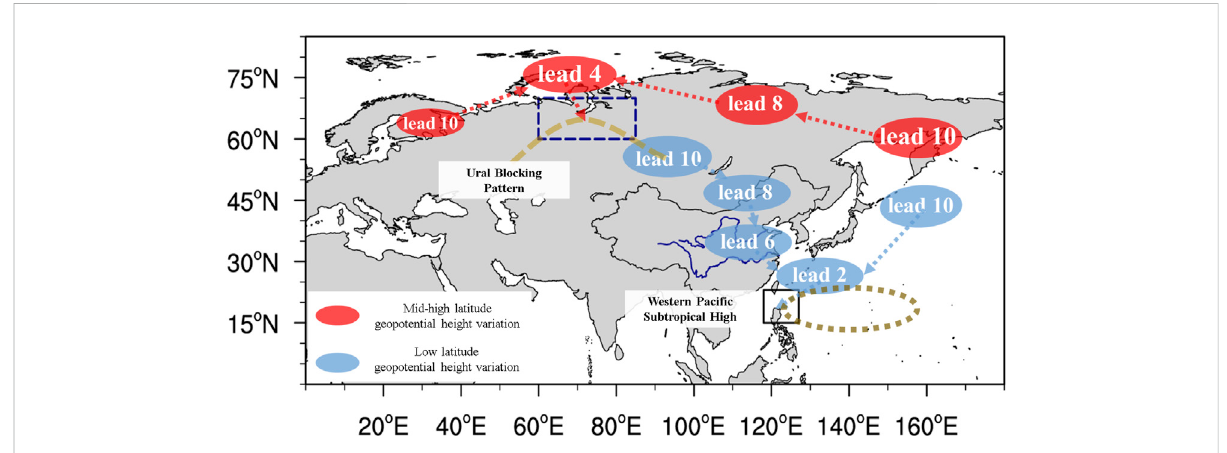
FIGURE 13 Schematic diagram of the evolution of atmospheric quasi-biweekly oscillations during Jiangnan Meiyu onset.